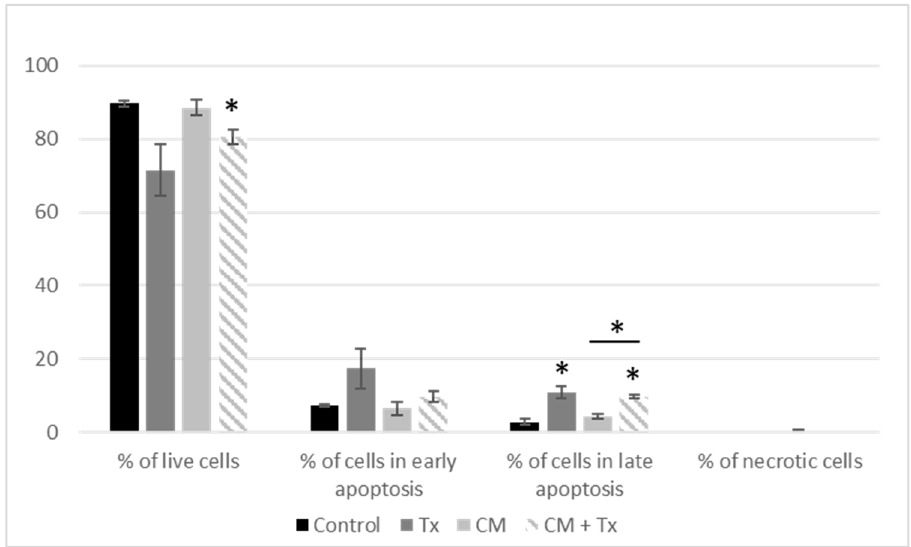
Figure 5. Evaluation of apoptosis after treatment of MCF-7 with conditioned media and tamoxifen. Results are expressed as percentage of MCF-7 cell growth ± SEM at 72 h post-treatment ( n = 3, * p < 0.05). [CM: conditioned medium; Tx: Tamoxifen].